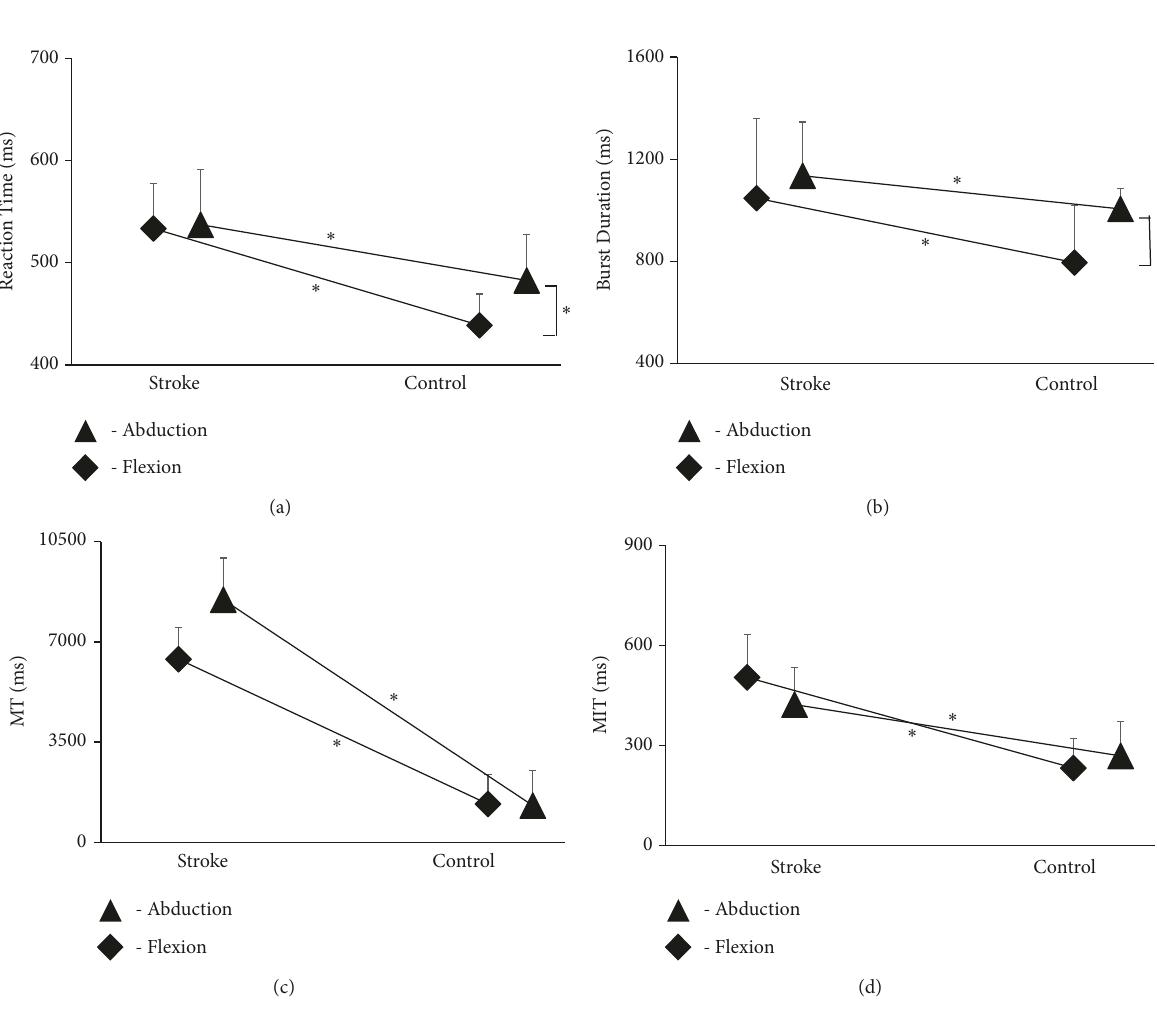
Figure 3: The data shows the effect of stroke on ipsilesional upper extremity in performance outcomes on (a) reaction time (ms), (b) burst duration (ms), and (c) movement time (MT) (ms) and (d) movement initiation time (MIT) (ms) compared to their healthy counterparts (p < 0.05) for both flexion- and abduction-reaching